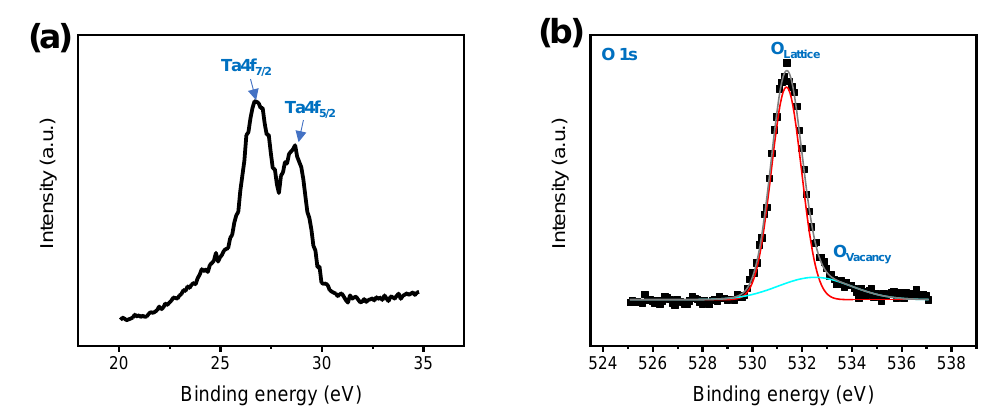
Figure 1. XPS spectra of TaO x film ( a ) Ta 4f and ( b ) O 1s.